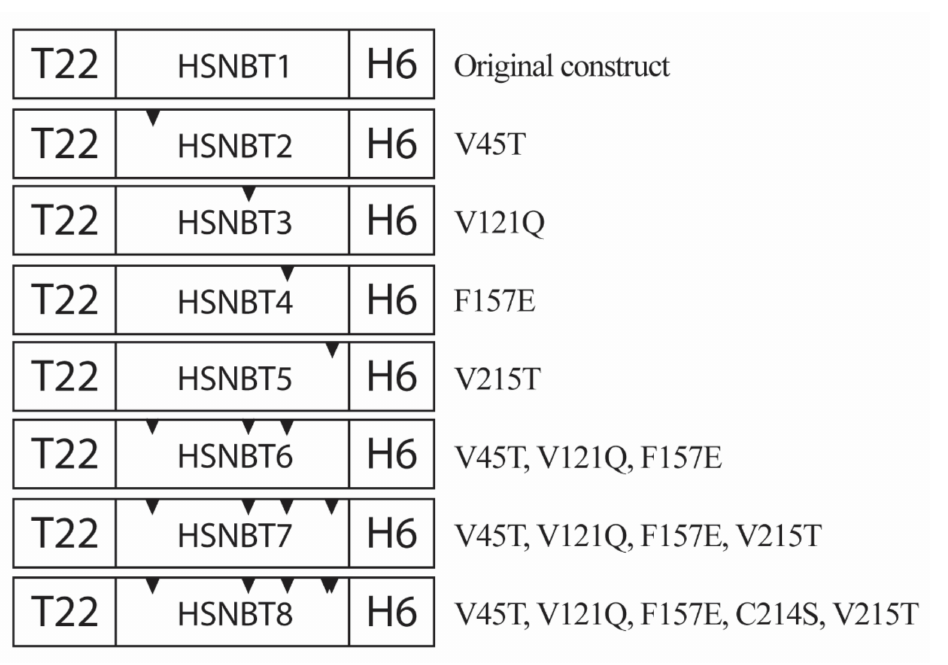
Figure 2. Modular design of the proteins derived from T22-HSNBT1-H6. Inverted black triangles indicate the approximate location of each chosen mutation in the core module of the scaffold protein. The precise position and nature of each mutation are indicated next to the modular construct, providing the original residue, its position in the sequence, and the new